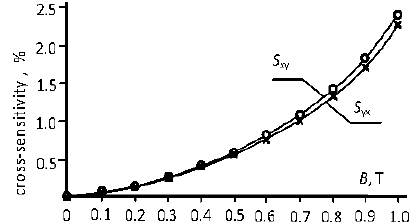
Figure 3. Channel cross-talk of 2D in-plane sensitive Hall sensor as a function of induction B at temperature T = 20